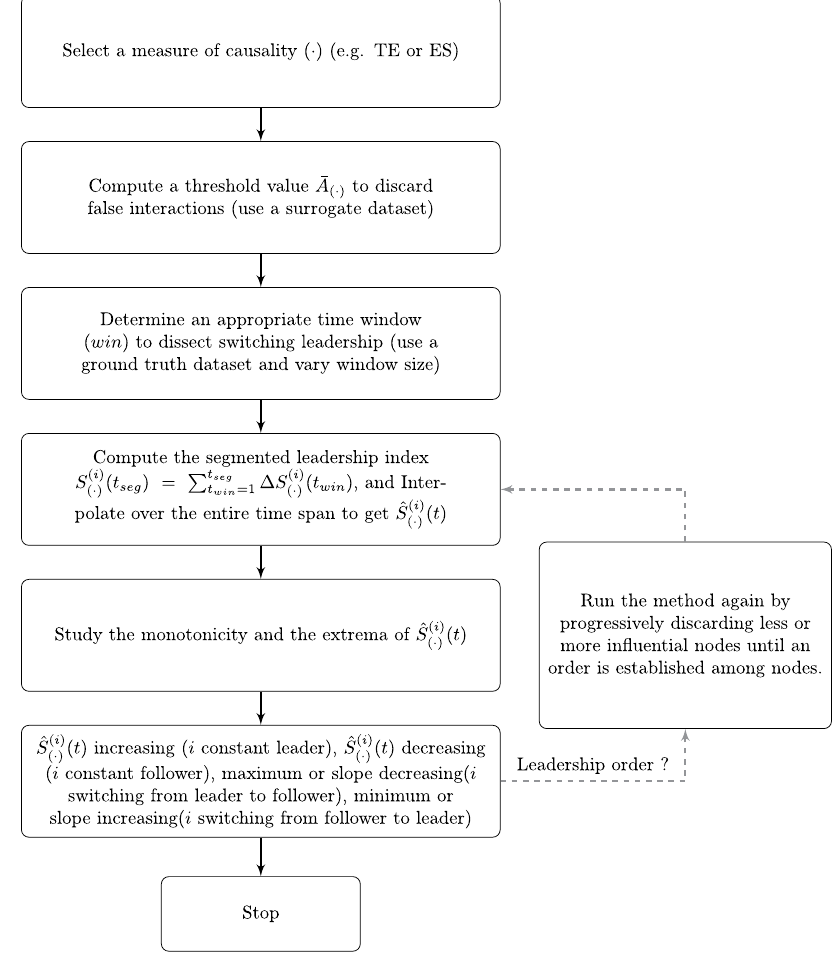
Figure 2. Steps to implement the method. The loop indicates the procedure to establish a leadership order in case of